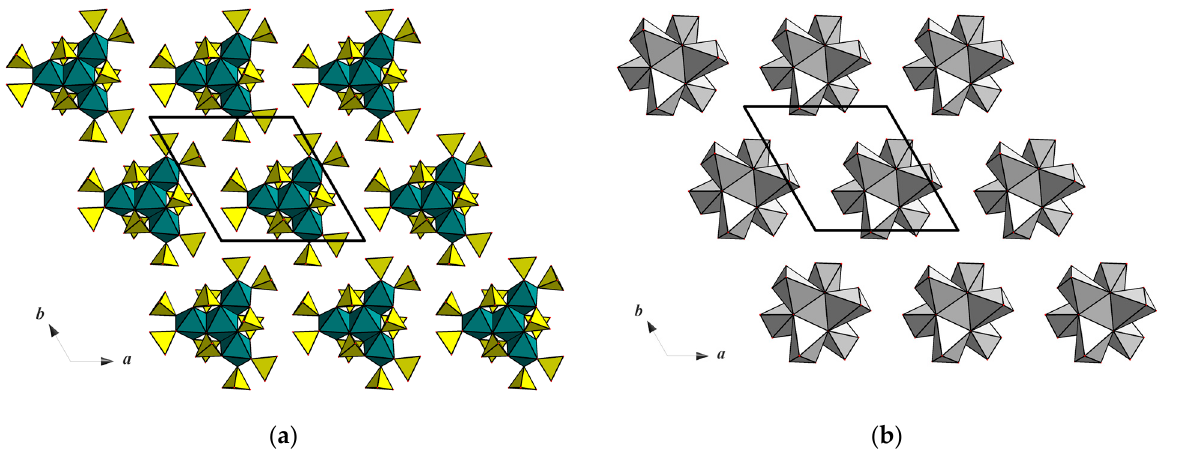
Figure 4. Layered “cut” of the crystal structure of Na 7 V 4 (PO 4 ) 6 on the ab plane: ( a ) clusters of four vanadium octahedra surrounded by PO 4 -tetrahedra and ( b ) clusters of sodium octahedra, both arranged according to the close-packing law.